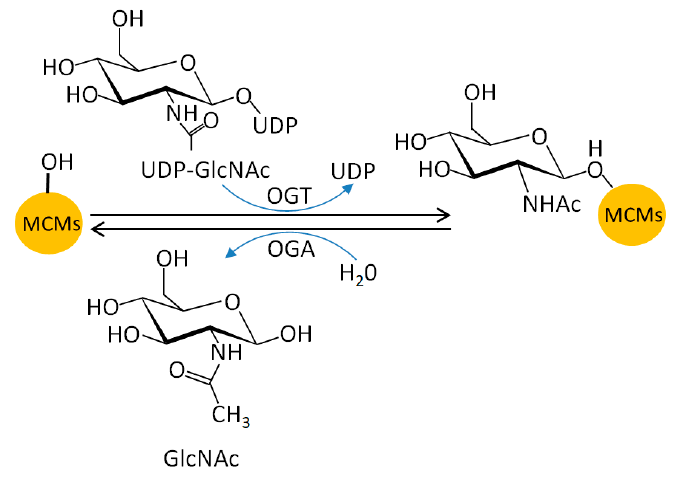
Figure 5. MCM O -N-acetyl-D-glucosamine (GlcNAc)ylation. OGT, O -GlcNAc transferase; OGA, O -GlcNAcase; UDP, uridine diphosphate.